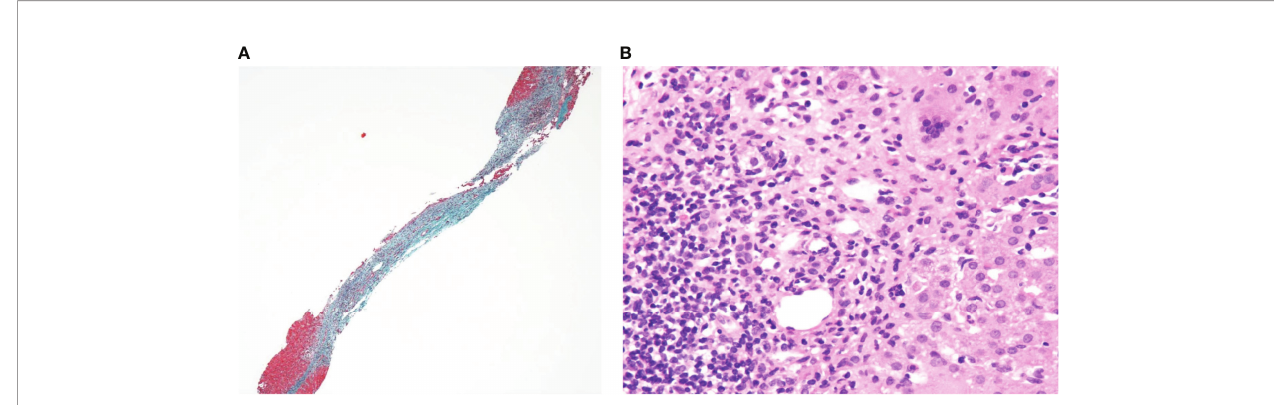
FIGURE 2 | (A) Elastica-Masson staining (×40) and (B) Hematoxylin and eosin staining (×200) of the liver